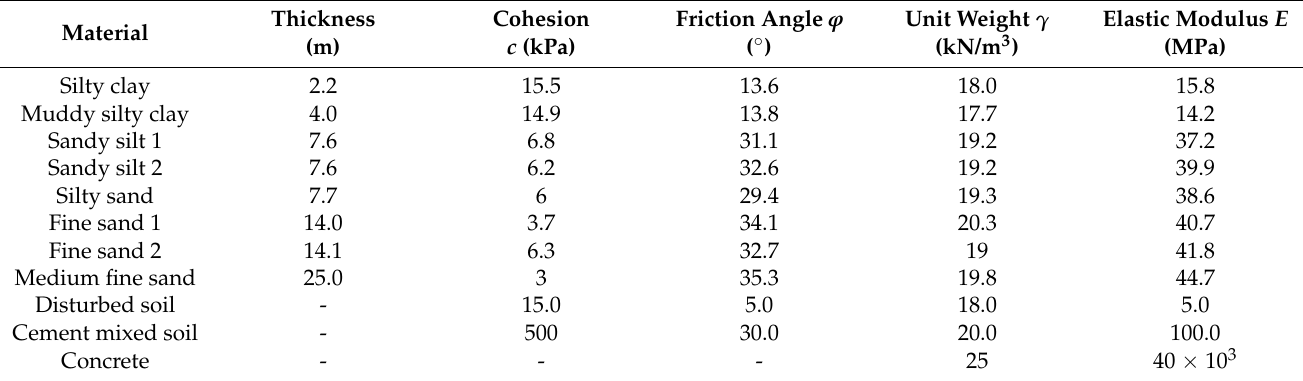
Table 1. Material parameters in the numerical model.